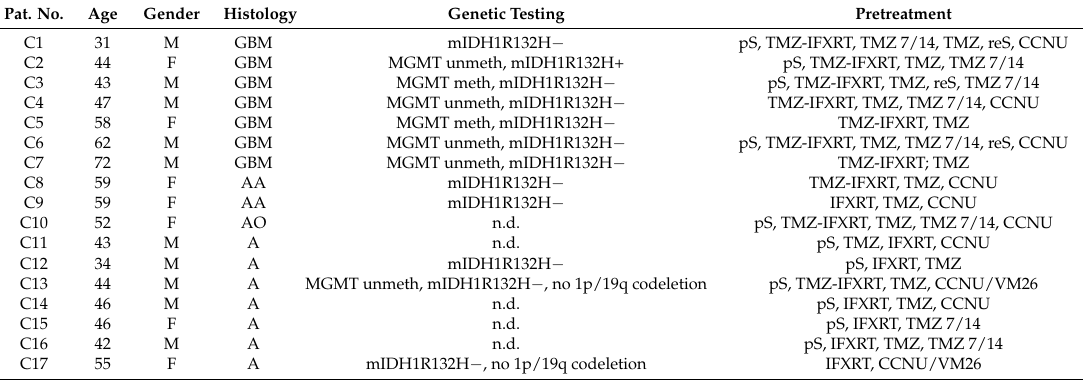
Table 4. Characteristics of the patients of the control group with a non-diffuse growth pattern. Pat. No.